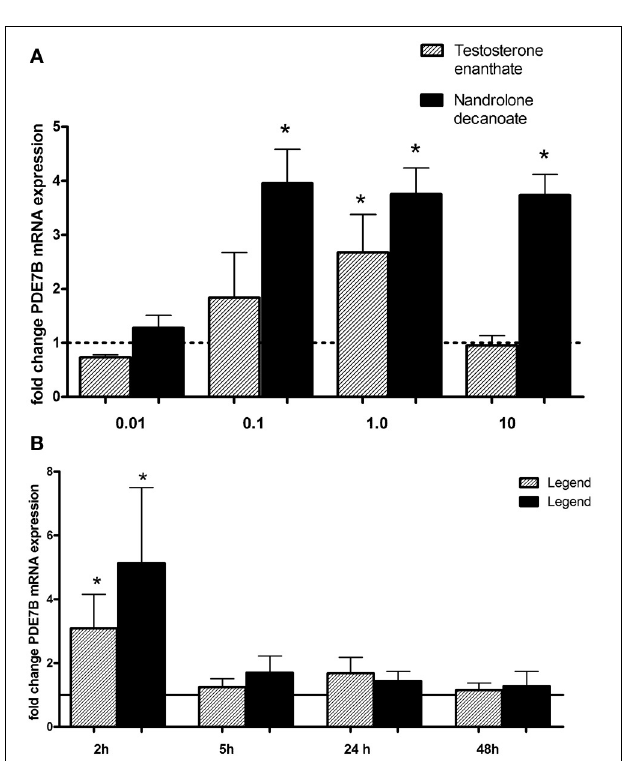
FIGURE 2 | Relative PDE7B mRNA levels in HepG2 cells after exposure to androgen esters at (A) different concentrations ( µ M) and incubation time of 2h and (B) different incubation time (hours) and a concen- tration of 1 µ M. The PDE7B gene expression was induced after 2h exposure. ∗ p < 0 .